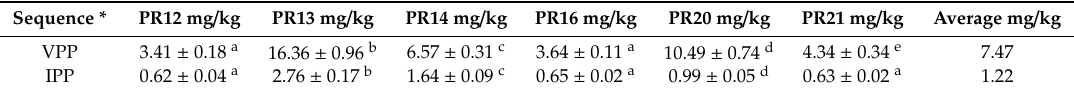
Table 2. Amount of VPP and IPP in the peptide fractions of Parmigiano Reggiano (PR) samples at 12 months of ripening belonging to the group HH (high-fat and high-salt). Sequence * PR12 mg / kg PR13 mg / kg PR14 mg / kg